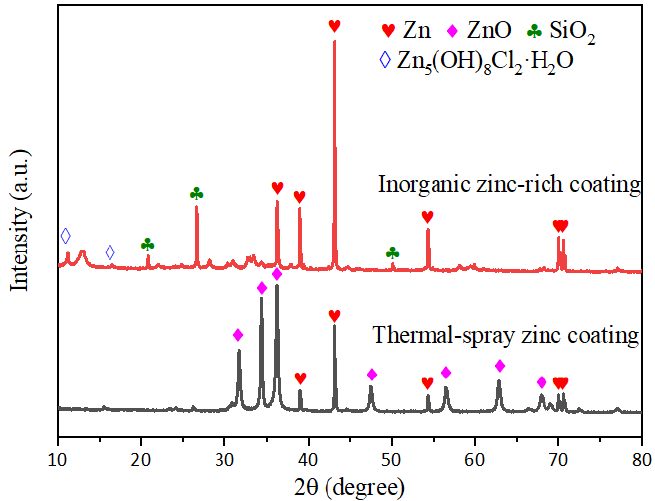
Figure 13. Analysis of the surface microstructure of the thermal-spray zinc coating: ( a , b ) SEM photograph and EDS pattern of thermal-spray zinc coating without salt spray; ( c , d ) SEM photograph and EDS pattern of thermal-spray zinc coating after salt spraying for 7500 h.